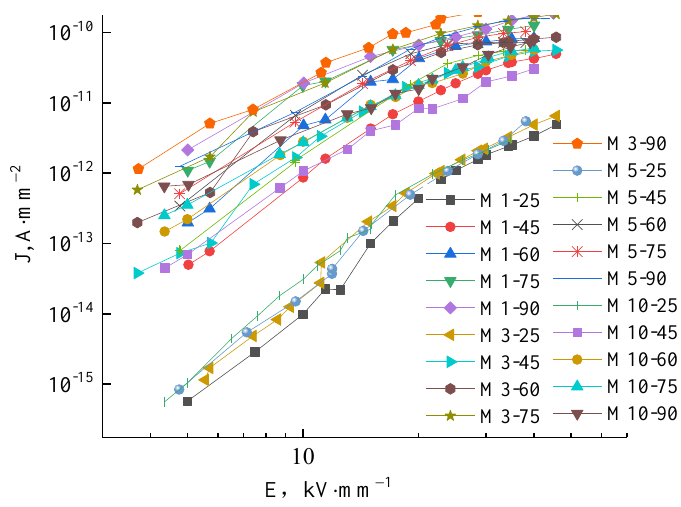
Figure 10. The J-E characteristic curves of M1, M3, M5 and M10 in different temperatures.